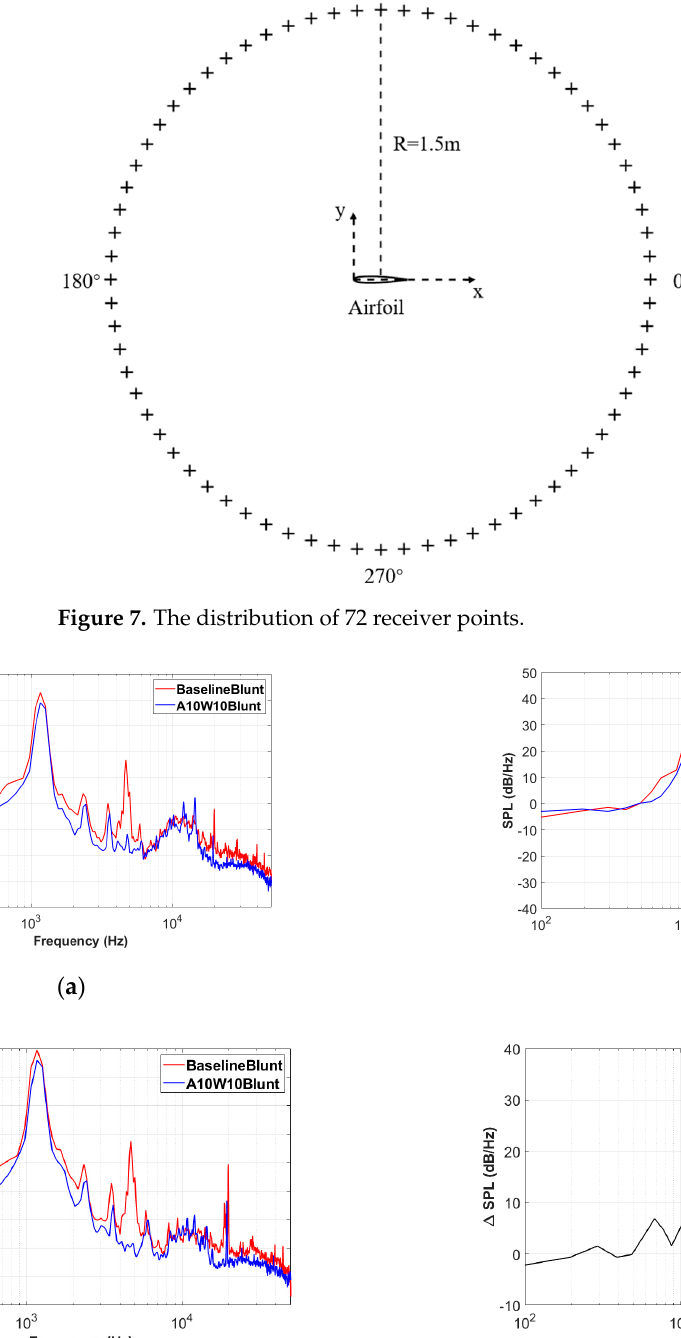
Figure 8. SPL reduction e ff ects of the wavy airfoil: ( a ) SPL at 60°; ( b ) SPL at 90°; ( c ) SPL at 120°; ( d ) Δ SPL at 90°.